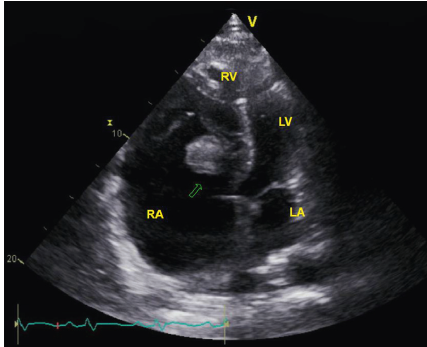
Figure 2: Subcostal view showing the tricuspid valve vegetation.